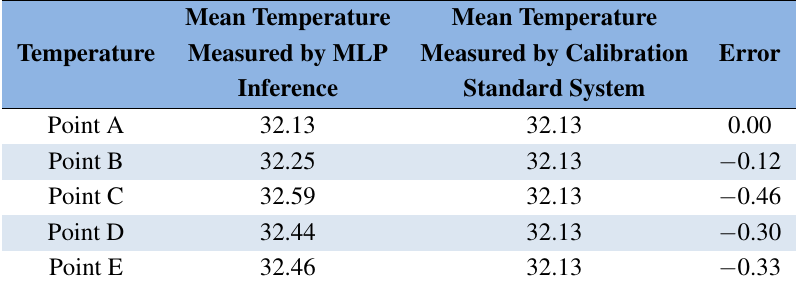
Table 4. Calibration results using the proposed system; control temperature = 32 ◦